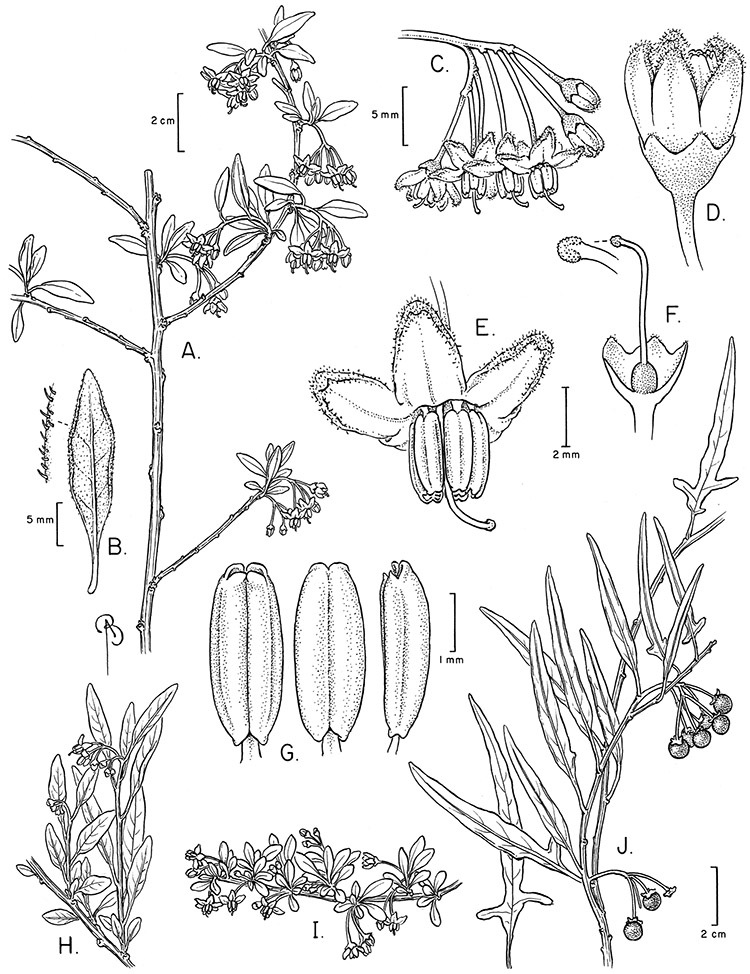
Solanum valdiviense Dunal. (A–G drawn from Taylor et al. 10282
H drawn from Taylor & Taylor 10843
I drawn from Werdermann 323). Illustration by Bobbi Angell.